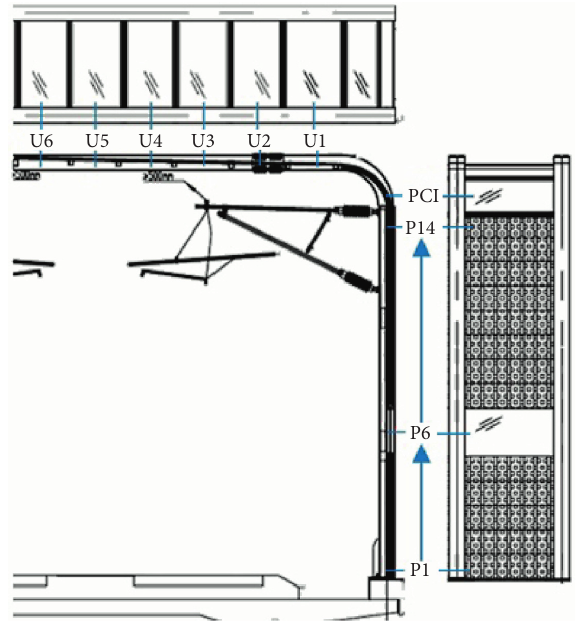
Figure 6: Layout of monitoring faces on the surface of SESB.